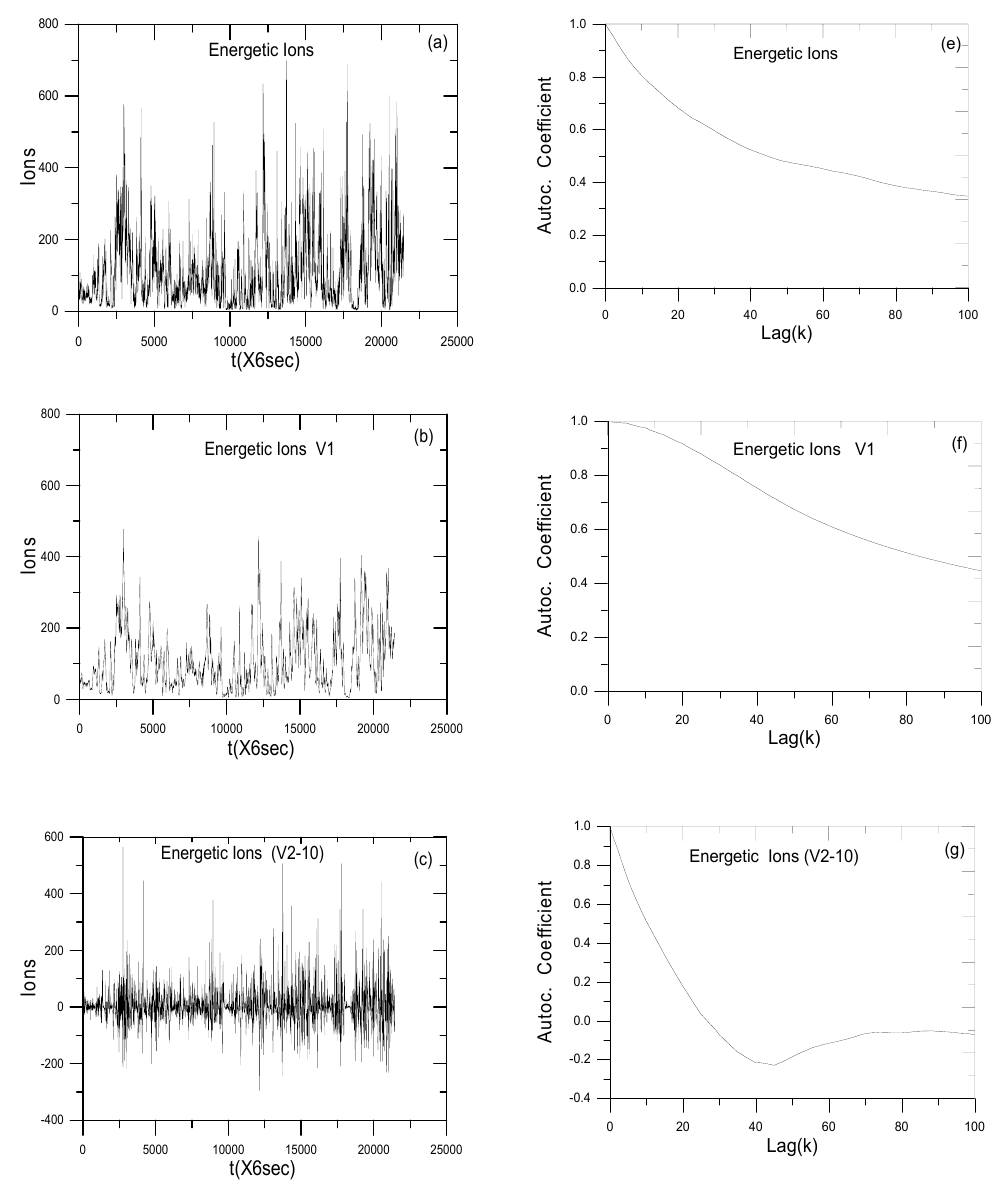
Fig. 12. (a) The magnetospheric energetic ions time series during the days 7–8 December 1994. (b) The time series corresponding to the V 1 component of the SVD analysis of the signal shown in (a). (c) The time series corresponding to the SVD reconstructed component V 2 − 10 = P V i ,(i = 2 − 10 ) , of the signal shown in (a). (e, f, g) The autocorrelation coefficient estimated for the signals shown in (a),(b),(c)